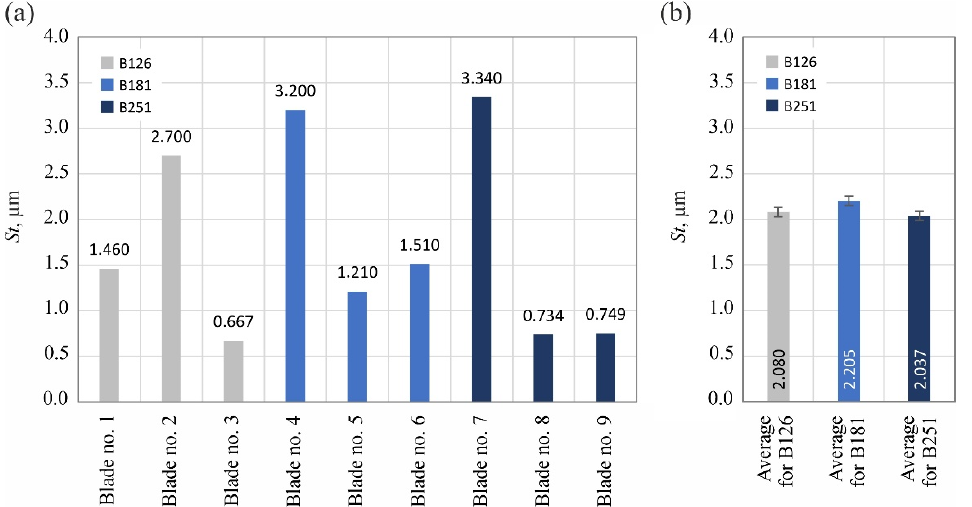
Figure 12. Changes in the total height of the surface St : ( a ) results for nine blades selected for surface texture measurements; ( b ) average values determined by the size of the cBN abrasive grain of the grinding wheel used (error bars represent the standard error equal to the standard deviation σ divided by the square root of the total number of samples).